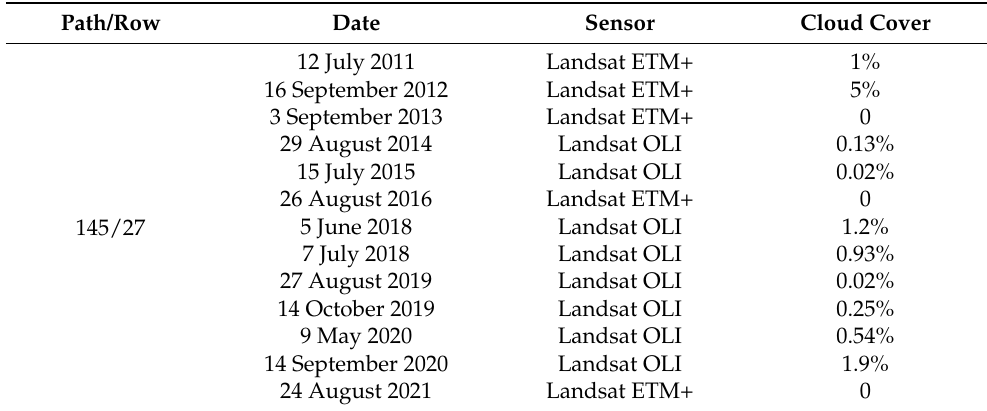
Table 1. Landsat images used to determine the SLA on the Muz Taw Glacier in the Sawir Mountains during the period